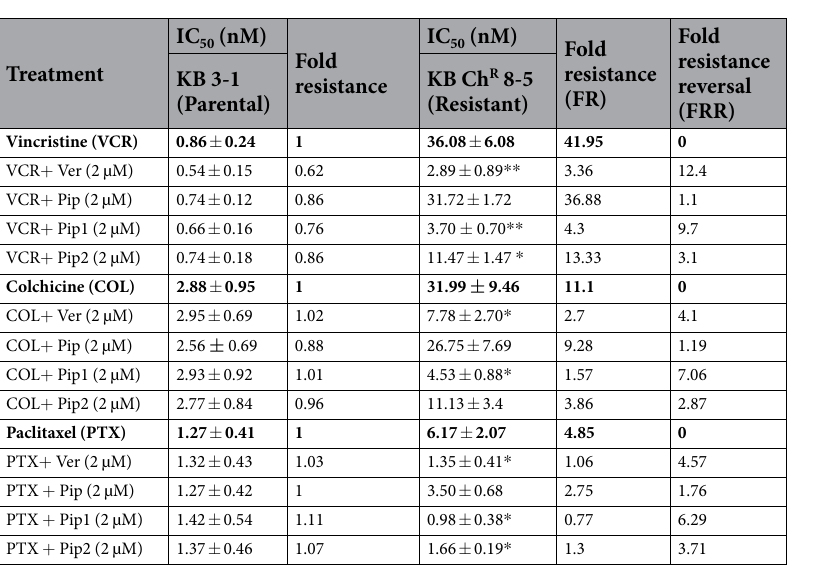
Table 2. The effect of piperine analogs on the reversal of resistance in KB 3-1 (parental) and KB Ch R 8-5 (resistant) cell lines on co-treatment with VCR/COL/PTX. * p < 0.05 and ** p < 0.005 versus VCR/COL/PTX treatment